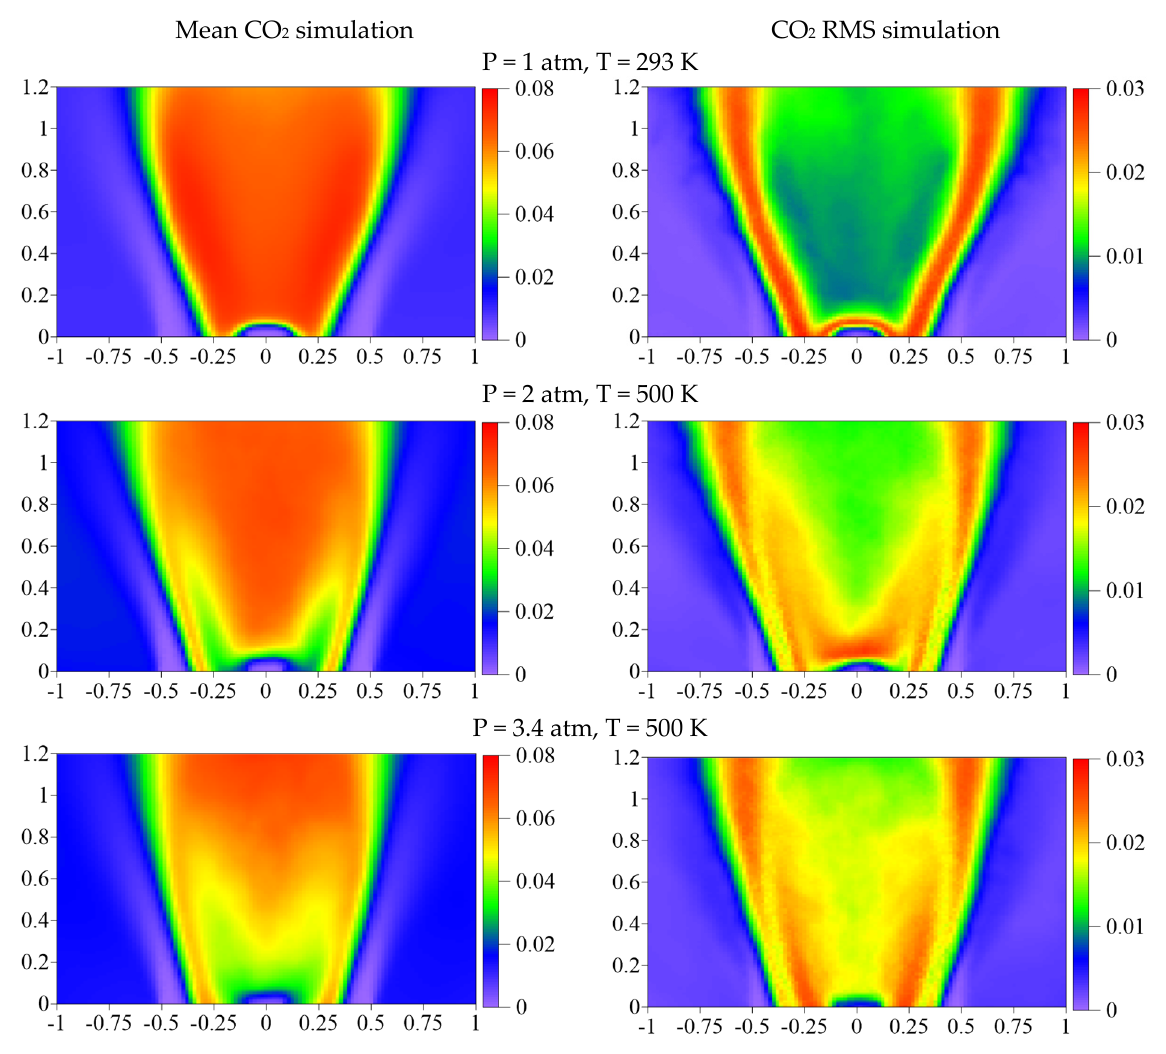
Figure 8. Mean CO 2 concentration fields and RMS of the concentration fluctuations evaluated by the LES approach.